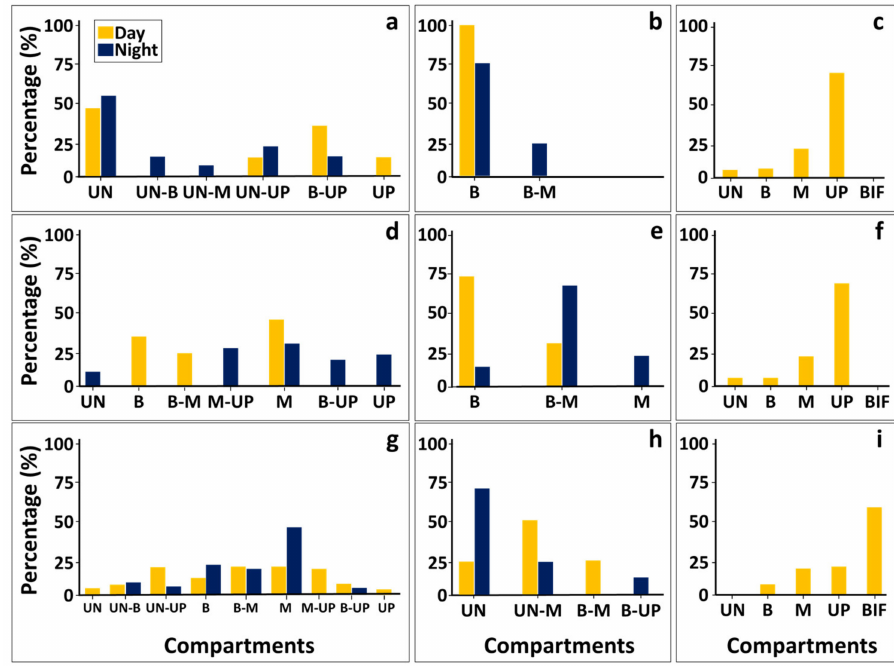
Figure 6. Proportion of Stylophora pistillata dwelling species according to their distribution between the canopy compartments during day and night censuses (mobile species), and for the sessile species (day surveys). ( a ) Ophiocoma sp.; ( b ) Alpheus lottini ; ( c ) Spirobranchus sp. ; ( d ) Sebastapistes cyanostigma ; ( e ) Paragobidon echinocephalus ; ( f ) Palaemonella rotumana ; ( g ) Pseudochromis olivaceus ; ( h ) Ophiactis sp.; ( i ) Leiosolenus lessepsianus . Percentage were calculated according to the total abundance of each species for each day time census (UN) understory, (B) base, (M) middle, (BIF) bifurcation nods; (UN-B) understory and base; (UN-M) understory, base, and middle; (UN-UP) understory, base, middle, and up; (B-M) base and middle; (B-UP) base, middle, and up; (M-UP) middle, and up